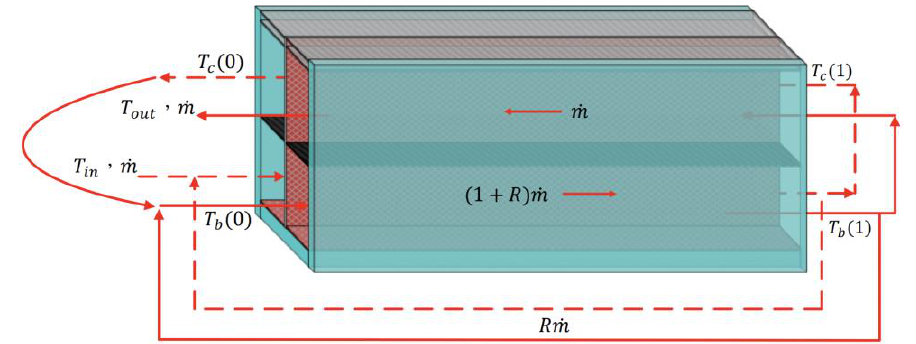
Figure 5. Schematic diagram of a recycling multi-pass solar air collector (Type B).